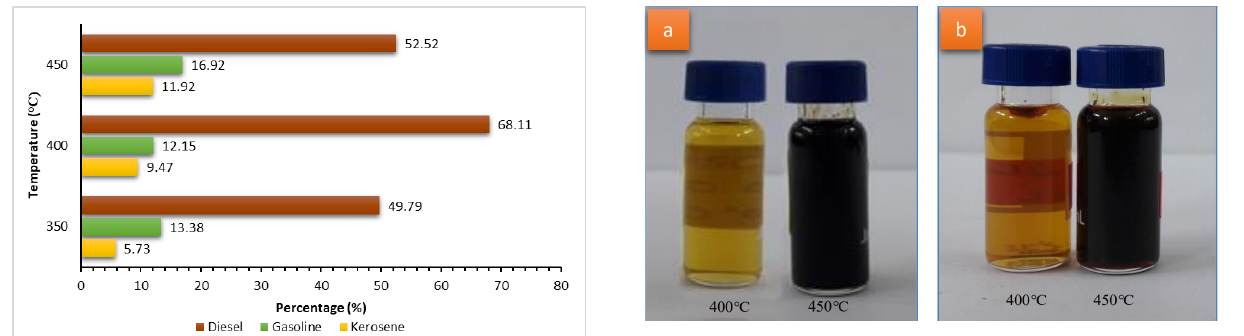
Fig. 5. Product selectivity in liquid hydrocarbon at different temperatures.